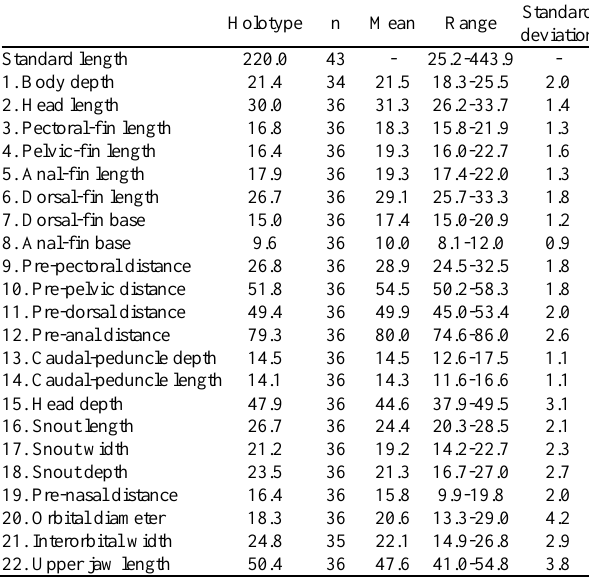
Table 1. Morphometric data of Hoplias australis . Standard length in mm; values 1-14 are percents of standard length and values 15-22 are percents of head length. n = number of examined